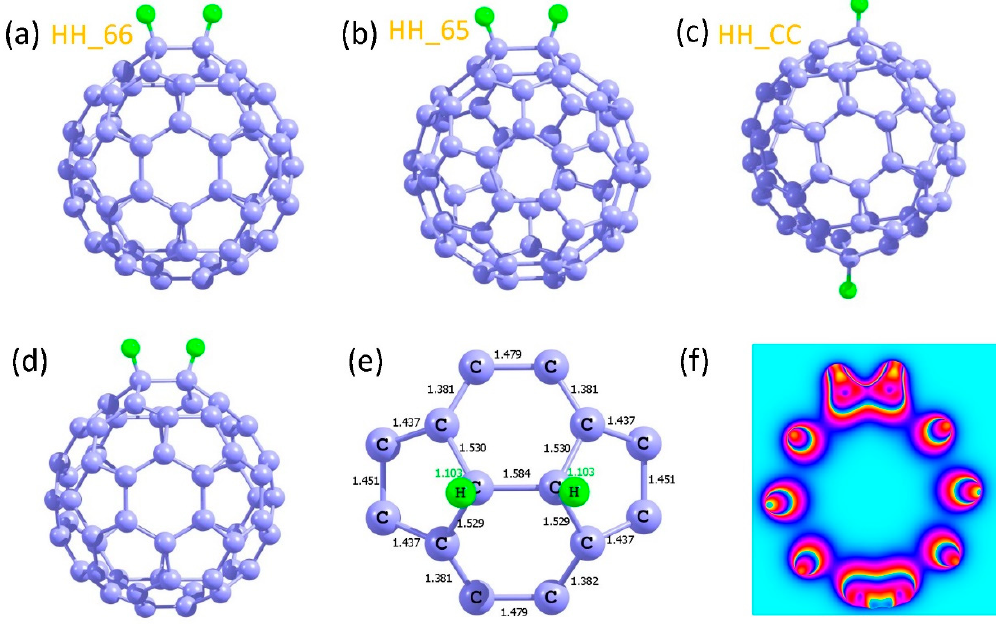
Table 3. Initial and final configurations of two single H atoms adsorbed on the surface of pristine C 60 , adsorption energies with respect to gas phase hydrogen atom and Bader charges on the H